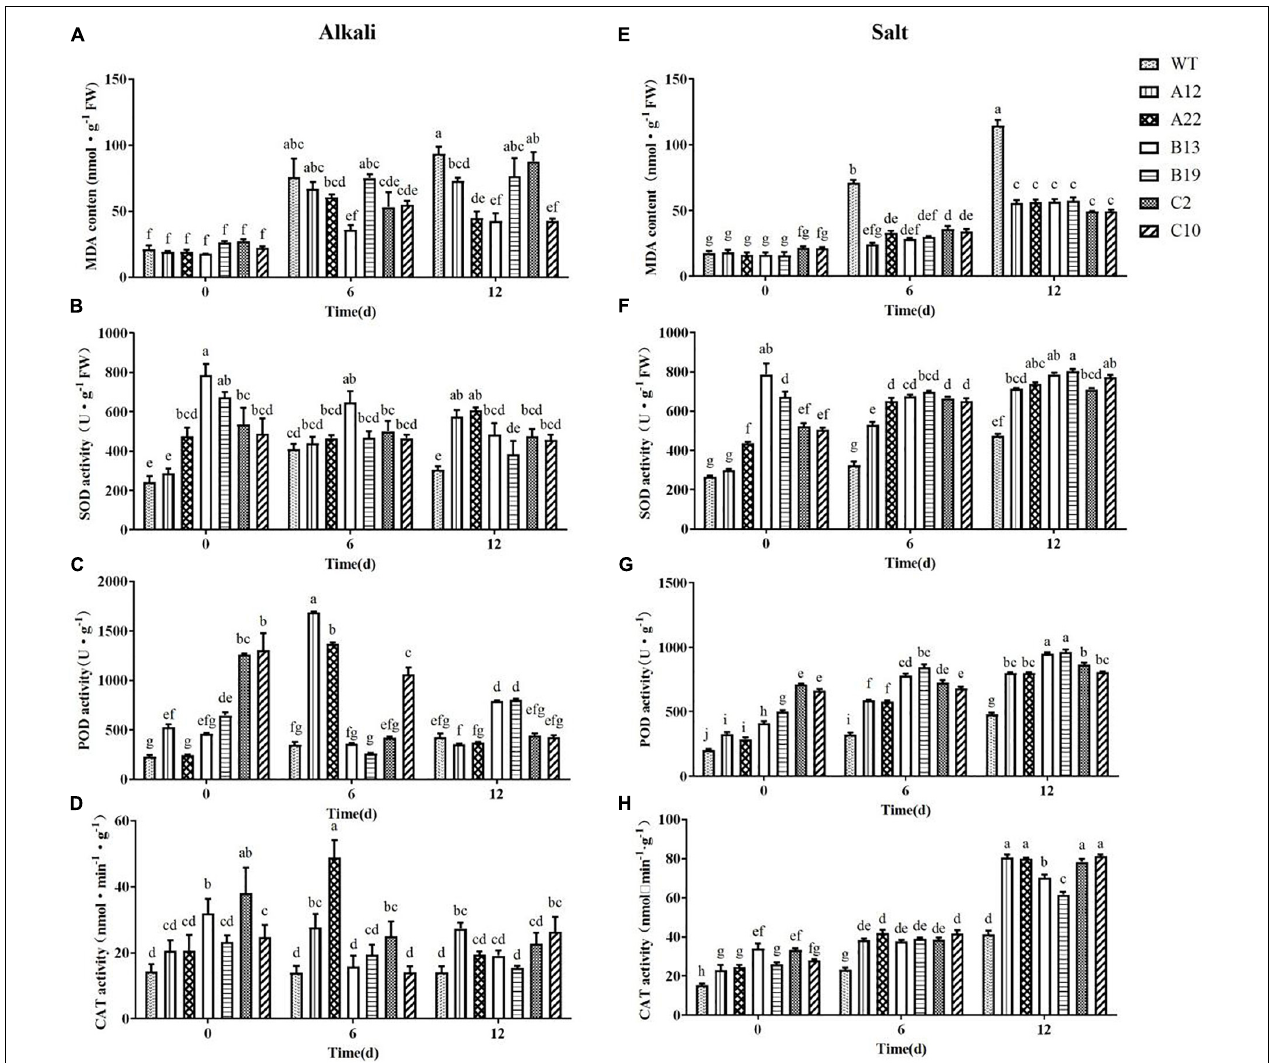
FIGURE 3 | MDA content, SOD activity, POD activity, and CAT activity in WT and transgenic alfalfa plants before and after alkali and salt treatment. Comparisons of the MDA content (A,E) , SOD activity (B,F) , POD activity (C,G) , and CAT activity (D,H) of the WT plants and transgenic alfalfa plants before and after 6 and 12 d of alkali and salt treatments. The values are the means ± SDs of three replicates (Duncan test: P <